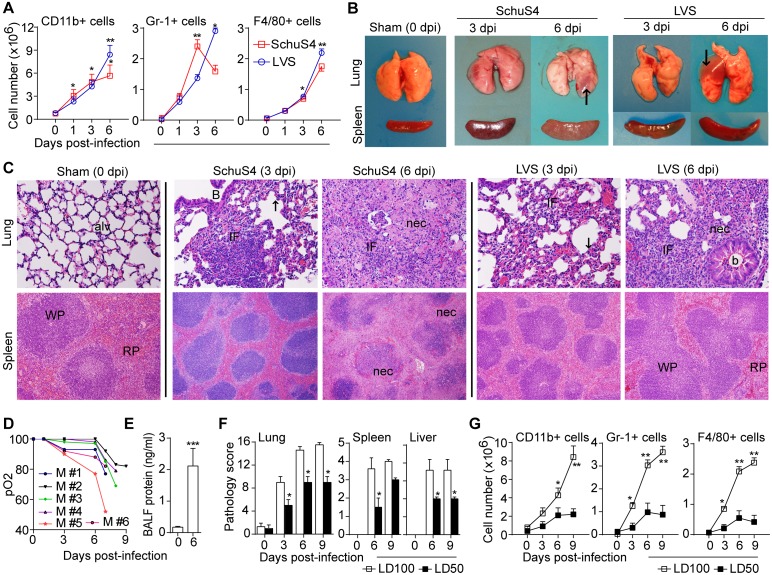
Overt inflammation is pathogenic and detrimental.(A) Total cell numbers of innate myeloid cells in lungs following LVS (1000 cfu) or SchuS4 (10 cfu) infection (mean ± SD of two (SchuS4, n = 6 mice) or three (LVS, n = 9 mice) independent experiments, Students t-test, *p<0.05, **p<0.01 for differences compared to uninfected mice at 0 dpi). (B) Gross pathology of lungs (arrows indicate consolidation) and spleen. (C) Histology of lung and spleen infected with SchuS4 or LVS, as shown in panel A. For lung (top): alv-alveolar wall, b-bronchiole, IF-inflammatory foci, and nec-necrosis. Note: hyaline membrane-like changes in alveolar epithelium (arrow) at 3 dpi indicating acute-lung injury, and necrotizing inflammation at 6 dpi (HE, 400x). For spleen (middle): WP-white pulp, RP-red pulp (He, 200x). For liver (bottom): granulomatous (arrow, 3 dpi) or necrotizing (arrow, 6 dpi) inflammation (HE, 200x). Microscopic images are representative of two independent experiments (n = 6 mice). (D) Oxygen saturation (SpO2) levels in individual LVS-infected (1000 cfu) mice through 9 dpi (all mice died by day 10) with a mean pO2 of 73.3 ± 11.6 of the last measurements prior to death). (E) Protein level in BAL fluid from control or LVS-infected (1000 cfu) mice at 6 dpi (mean ± SD of two experiments, Student’s t-test, *** p<0.001). (F) Comparative pathology scores for lungs, spleen and liver of lethal (1000 cfu) vs sub-lethal (500 cfu) Ft LVS infection. Pathology score was calculated by analysis of section of whole lung (n = 6 mice) for location/type/and extent of inflammation and necrosis (see Methods) (mean ± SD of two experiments, Mann-Whitney test, *p<0.05). (G) Myeloid cell number in lungs for lethal (1000 cfu) vs sub-lethal (500 cfu) Ft LVS infection (mean ± SD of two independent experiments (n = 8 mice), Students t-test, *p<0.05, **p<0.01).